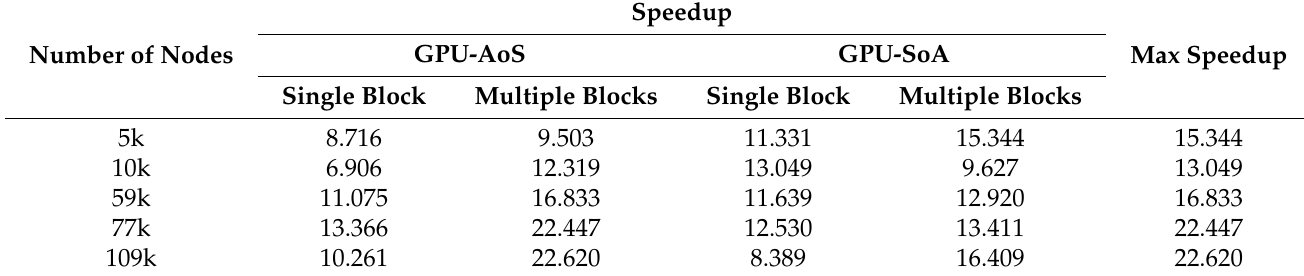
Table 6. Speedup of the proposed algorithm over serial algorithm when using Form